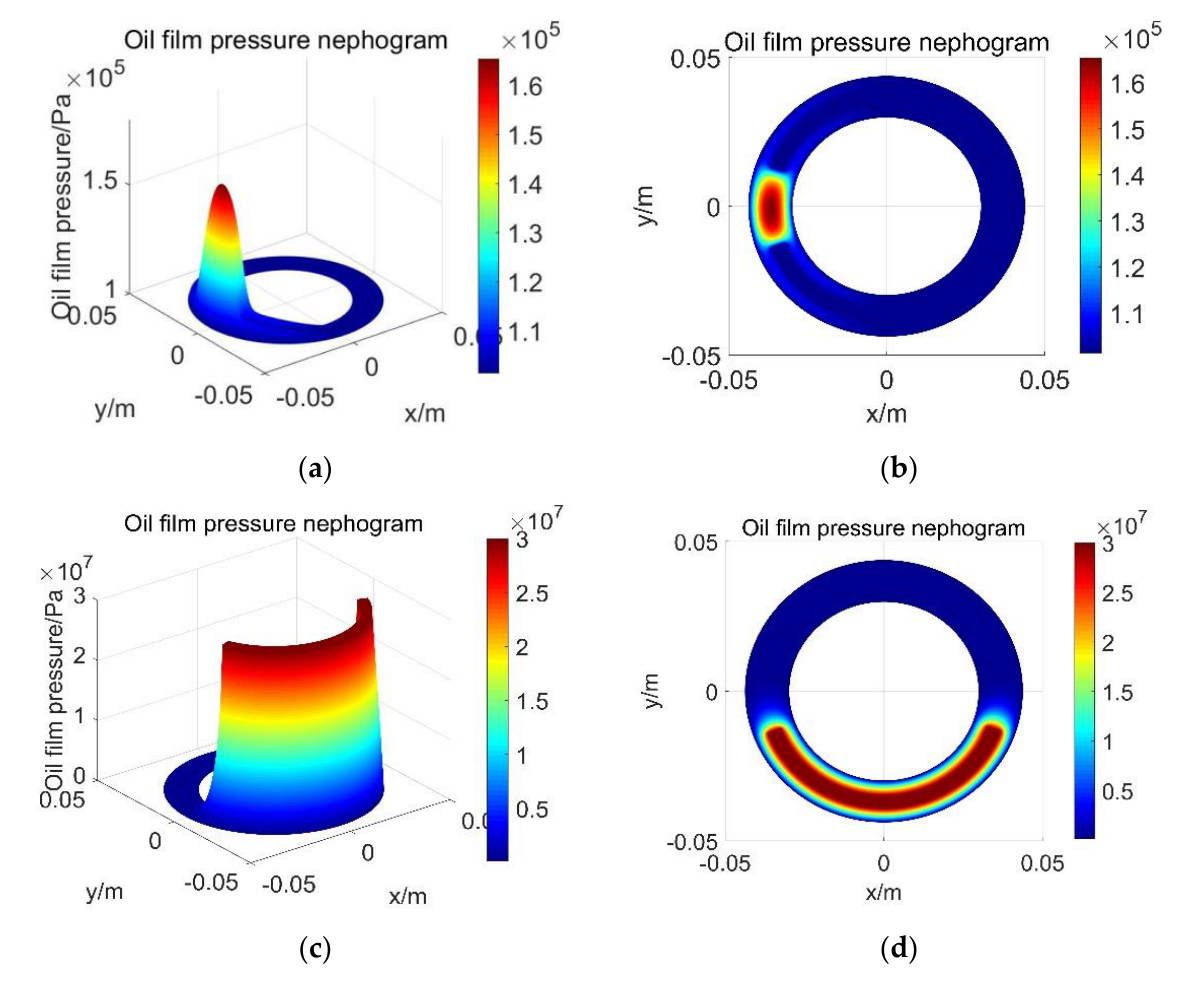
Figure 5. Oil film pressure distribution ( a ) pressure distribution 3D diagram; ( b ) pressure distribution top view; ( c ) pressure distribution 3D diagram under 35 MPa; ( d ) pressure distribution top view under 35 MPa.